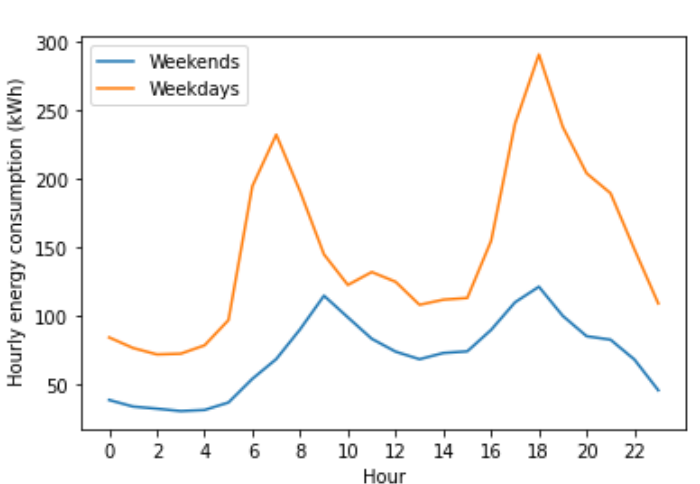
Figure 9. Elbow curve.